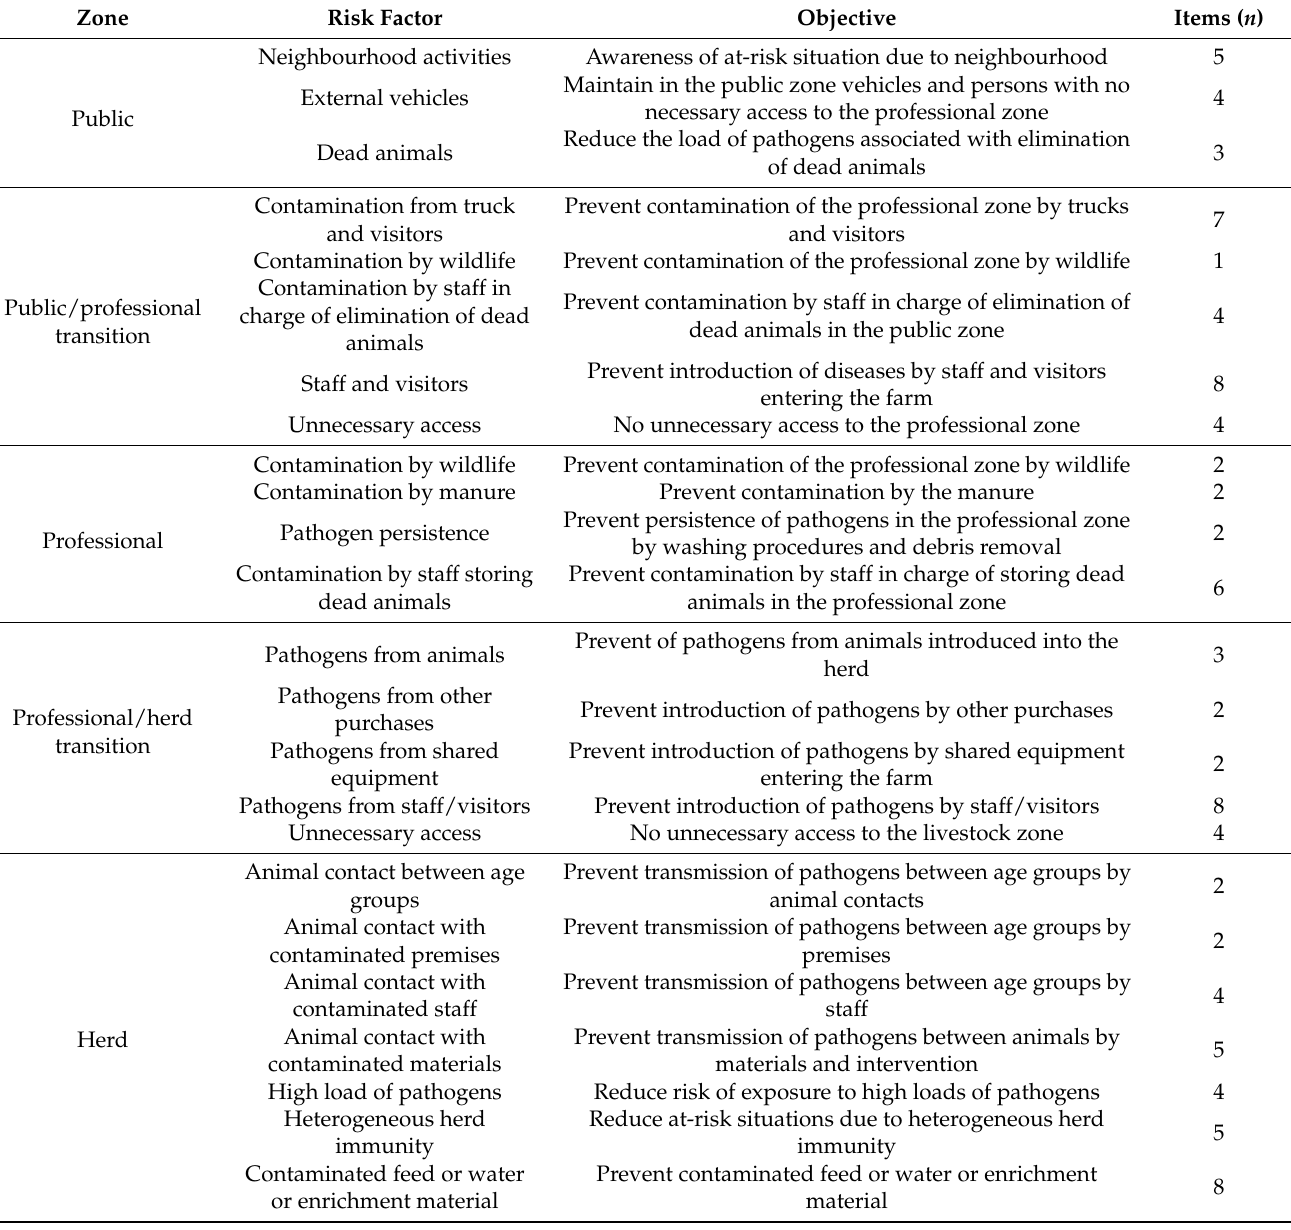
Table 1. Risk factors, their objective and number of questions in each of the five zones of the biosecurity